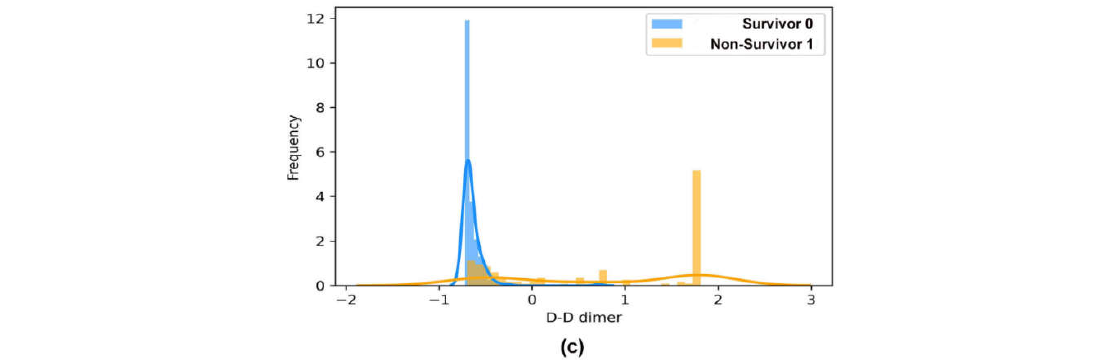
Figure 4. The histogram represents the frequency distribution across the two classes of population (non-survivor and survivor) of the four optimal blood biomarker subset obtained using the WOA meta-heuristic technique. ( a ) Platelet large cell ratio, ( b ) D-dimer, and ( c ) international standard ratio.